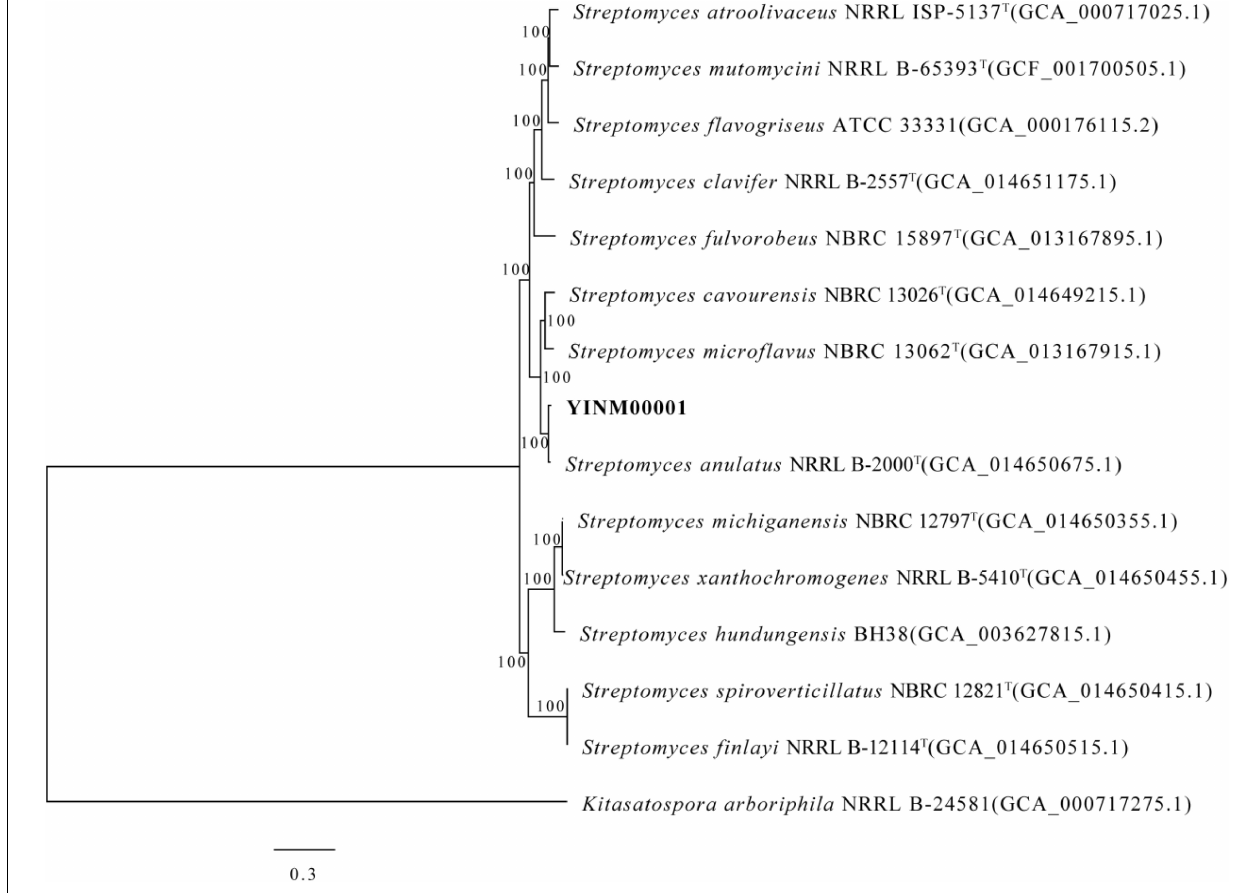
FIGURE 3 | The RAxML phylogenomic tree of strain YINM00001 and its closest relatives from the genus Streptomyces based on marker genes. Bootstrap values ( > 70%) based on 1,000 resamplings are given at the nodes. Kitasatospora arboriphila NRRL B-24581 (accession no. GCA_000717275) was used as outgroup. Bar, 0.3 substitutions per nucleotide